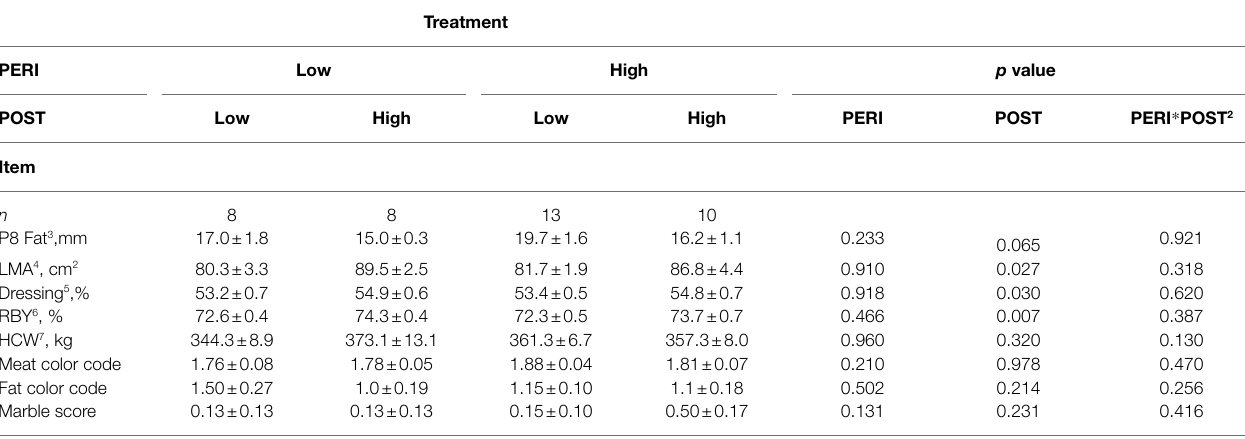
TABLE 4 | Carcass characteristics of bulls at slaughter at 598 days of age following exposure to maternal diets low or high in protein during the peri-conception and first trimester periods of gestation 1 .